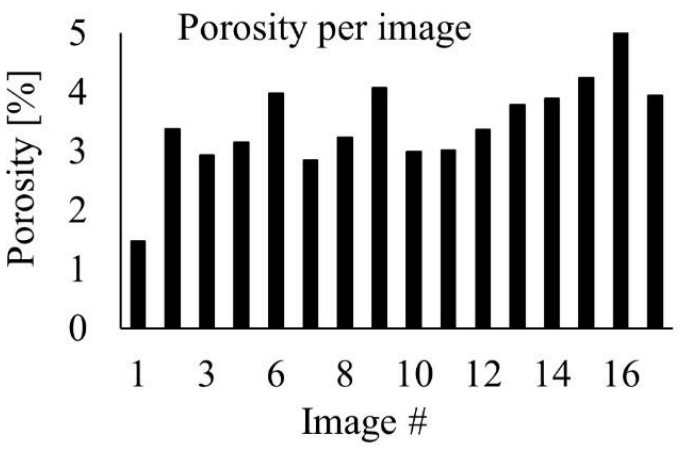
Figure 11. Histogram showing the average porosity of the individual images.